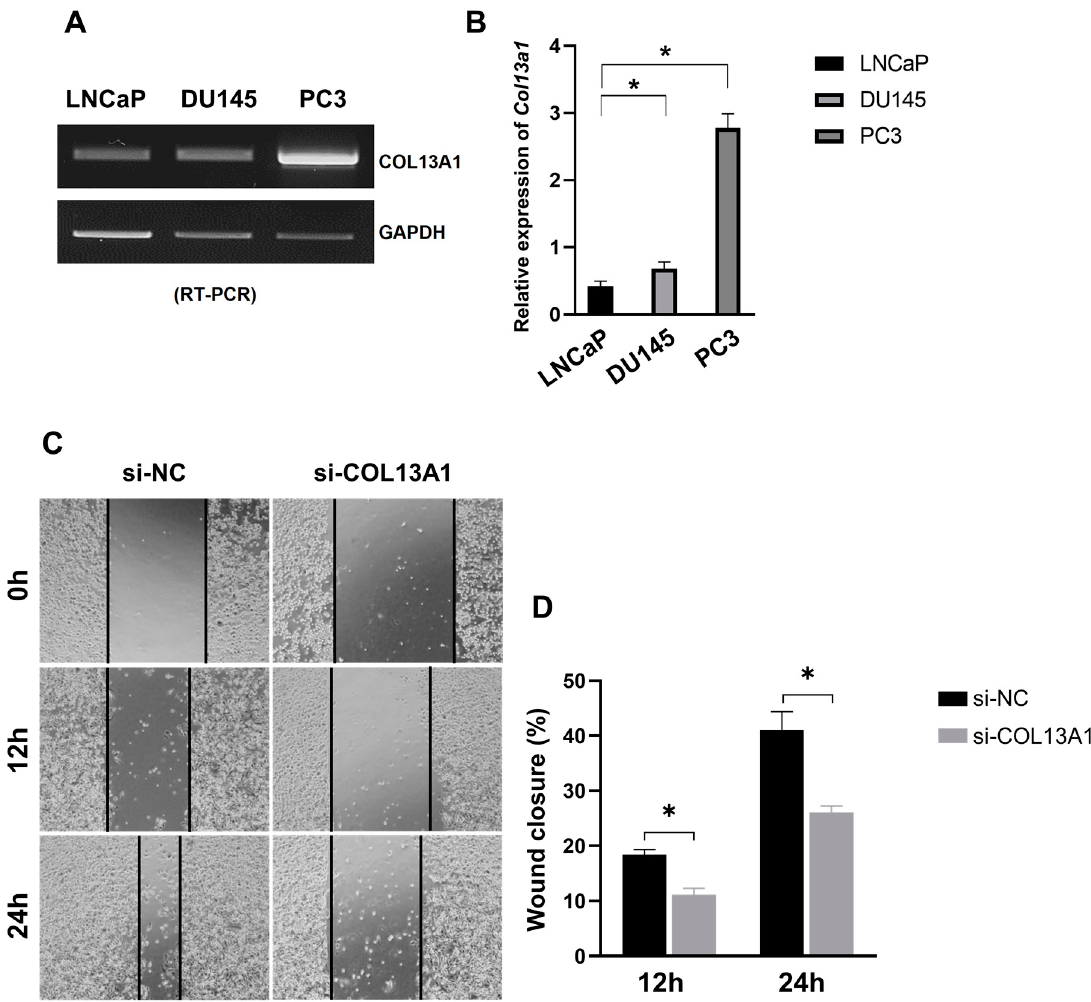
Figure 6. Expression of COL13A1 in LNCaP, DU145, and PC3 prostate cancer cell lines. ( A ) mRNA expression of COL13A1 in three differently originated prostate cancer cell lines. ( B ) Bar graph of the relative expression of COL13A1 in several prostate cancer cell lines. ( C ) Representative image of wound healing assay in control and hypoxia-resistant cells. ( D ) Bar graph represents the percentage of scratch closure. Data are mean ± SEM. * p < 0.05.